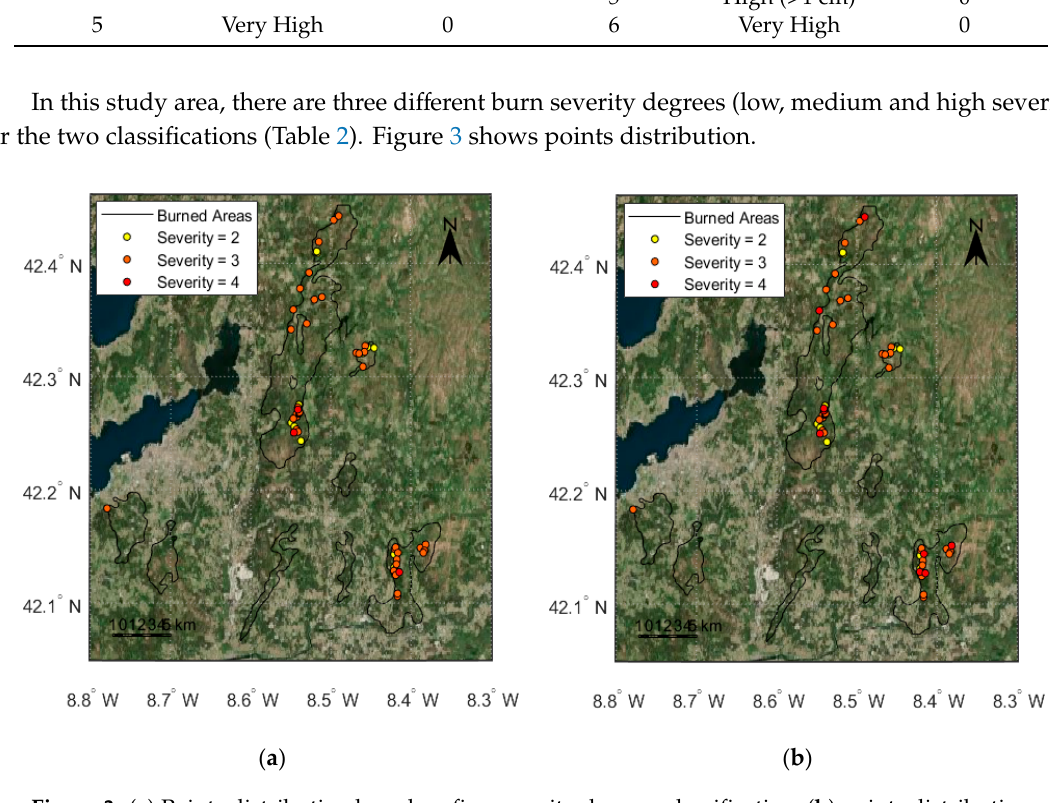
Figure 3. ( a ) Points distribution based on five severity degrees classification; ( b ) points distribution based on six severity degrees’